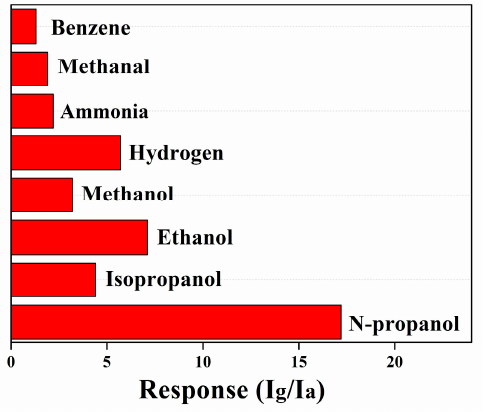
Figure 12. Responses of the GO-decorated porous single-crystalline ZnO nanosheets to 50 ppm of various gases at 300 °C. Table 1. N − propanol sensors based on metal oxide nanostructures.